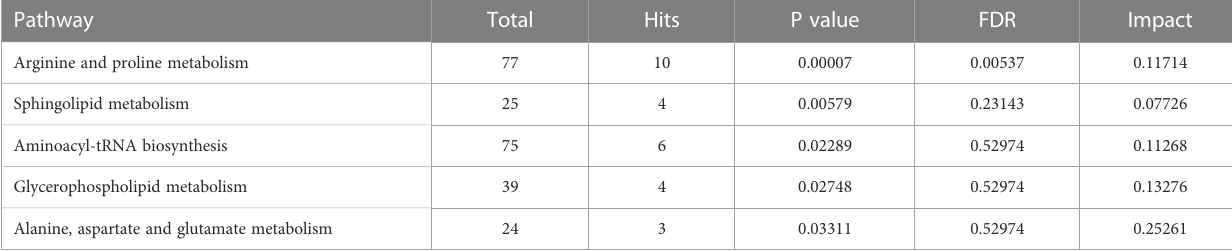
TABLE 1 Signi fi cant pathways in positive-ion